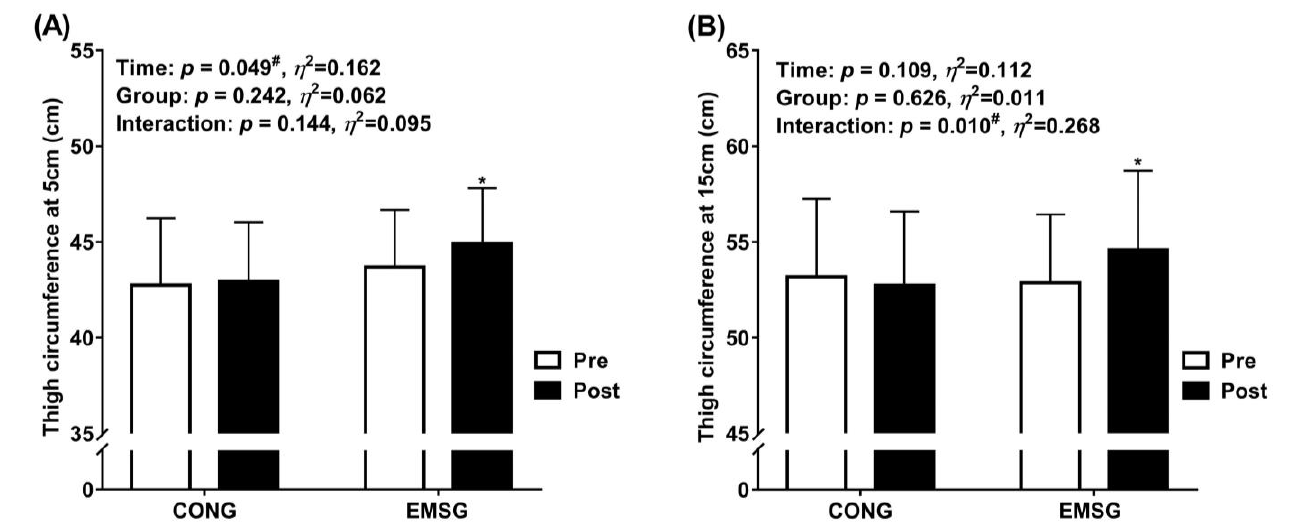
Figure 5. The rehabilitative exercise programs’ effects on circumference at 5 cm and 15 cm. ( A ) Com- pared in 5 cm circumference. ( B ) Compared in 15 cm circumference. control group; CONG electro muscle stimulation group; EMSG. # p < 0.05: main effect or interaction; * p < 0.05: pre- and post-test.